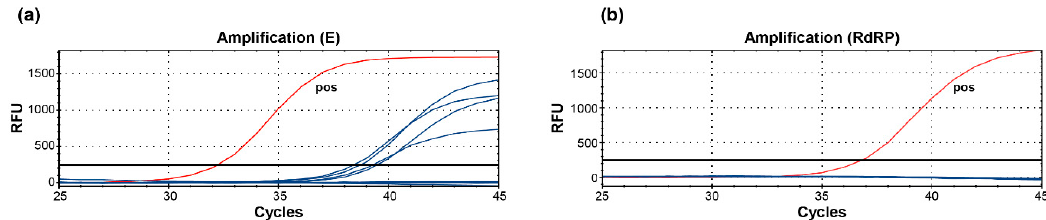
Figure 1. The WHO E-gene PCR for the pre-screening for SARS-CoV-2 using in vitro diagnostic (IVD)-certified test kits (Roche) produces unspecific, template-independent side-products. ( a ) Detection of SARS-CoV-2 false-positive samples (Pat. 20–23) tested with primers targeting the E-gene. ( b ) Confirmatory PCR using SARS-CoV-2 RdRP-specific primer and probe. RFU, relative fluorescence units; pos , positive control SARS-CoV-2 positive Pat.1.